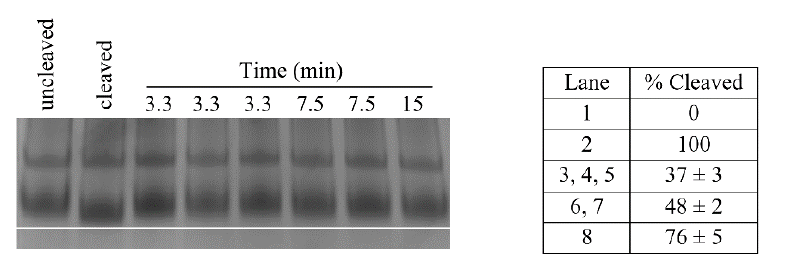
Figure 8. S. aureus Pth1 Kinetic Data. Shown is a representative time course of substrate cleavage by Pth1 from S. aureus . Uncleaved indicates the negative control, enzyme substrate or peptidyl-tRNA. Cleaved indicates the positive control, enzyme product or peptidyl-tRNA fully cleaved to free tRNA. A white line was added to better visualize the band shift. To the right is a table that shows the percent of substrate cleaved ± standard deviation, calculated from migration